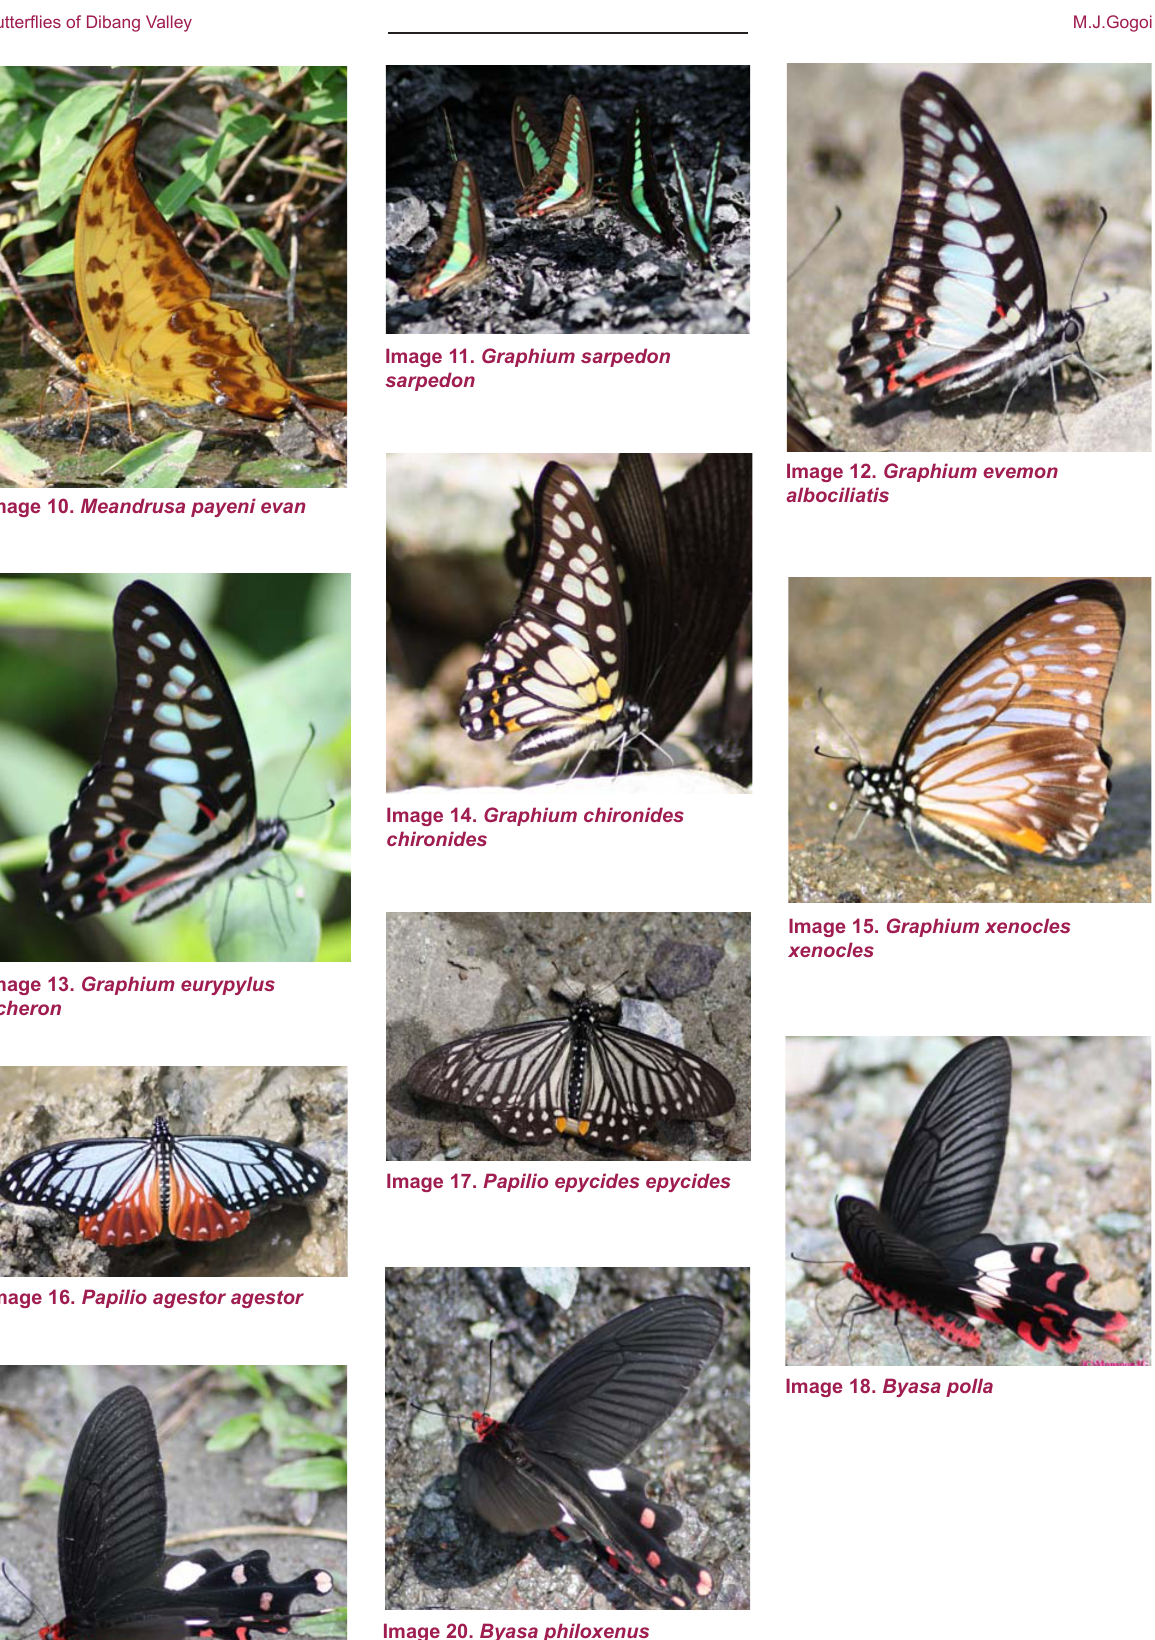
Image 20. Byasa philoxenus